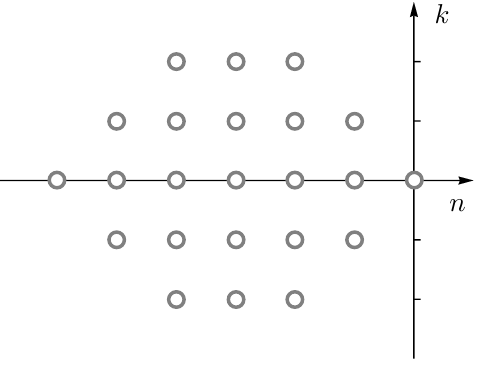
Figure 7 . The set of points in the recurrence relation for the coe(cid:14)cients w ( m + n; j + k S